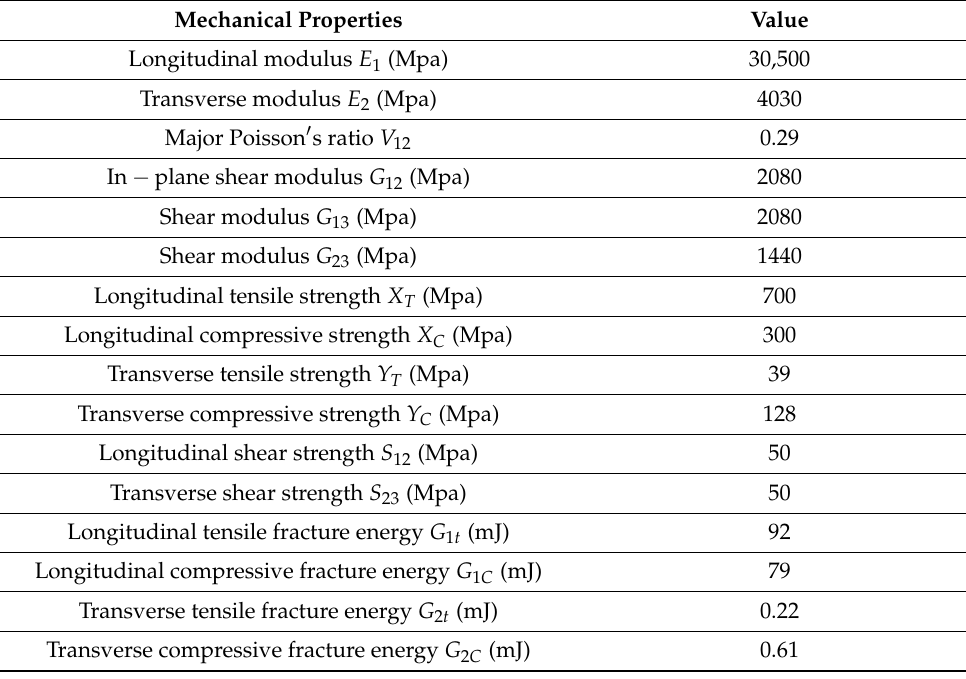
Table 2. Material properties of the E-glass/Epoxy composite.